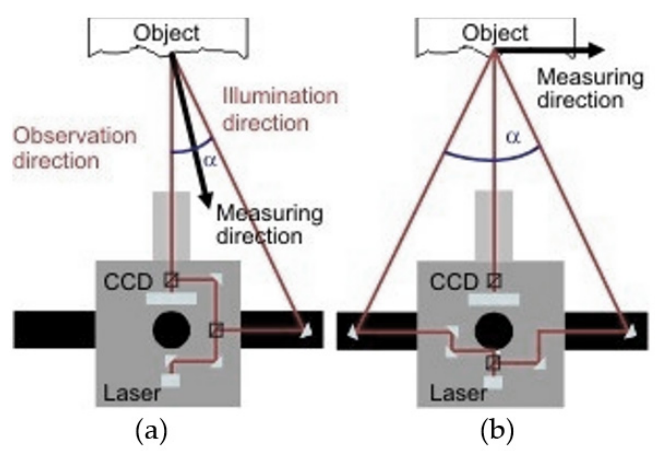
Figure 1. ESPI setup for ( a ) out-of-plane, ( b ) in-plane measurements.